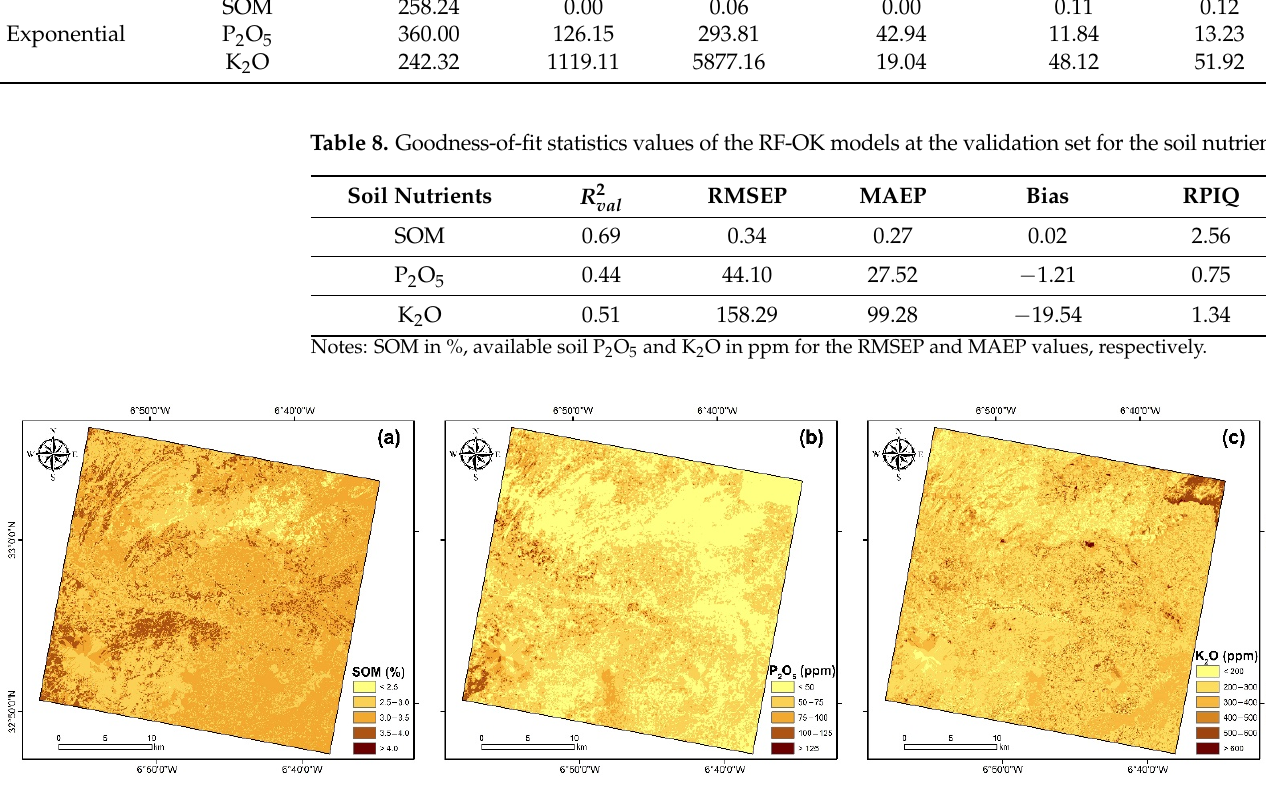
Table 7. Semi-variogram results of soil nutrients estimated residuals by RF-OK models. Model